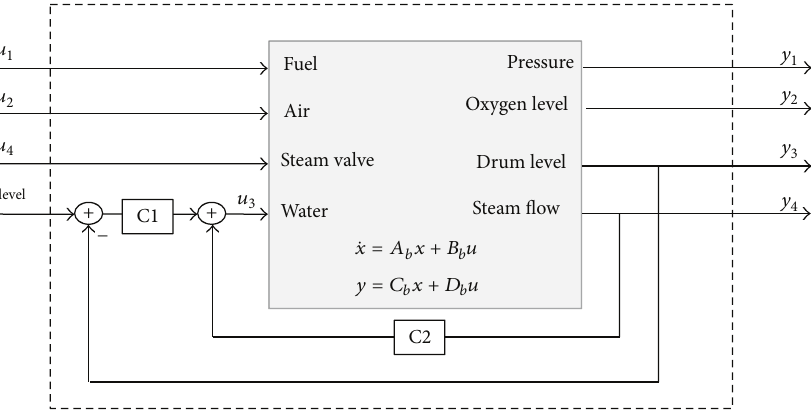
Figure 4: Stabilization scheme for the boiler.